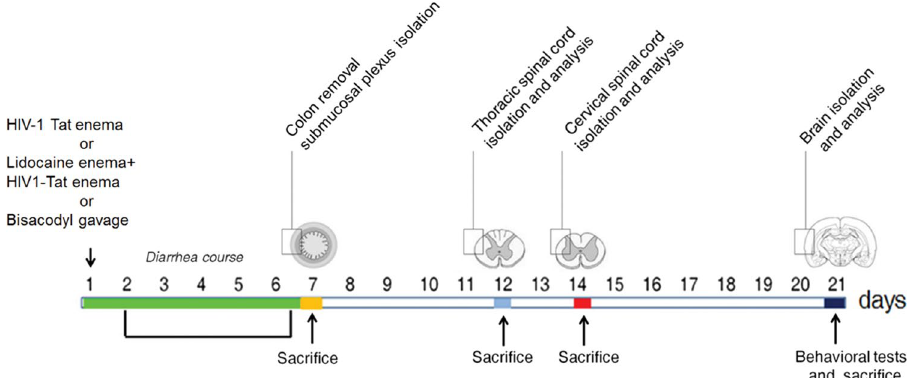
Figure 1. Schematic representation of rats-induced diarrhea. Diagram showing the induction of diarrhea by a single intracolonic administration of HIV-1 Tat, alone or in the presence of lidocaine, or by a single dose of bisacodyl, and the time schedule for measurements on enteric, or central nervous system glia